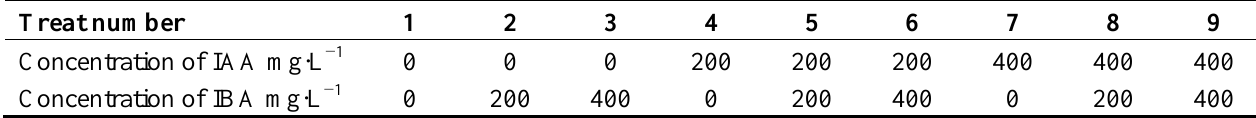
Table 6. The experimental design of IAA and IBA.